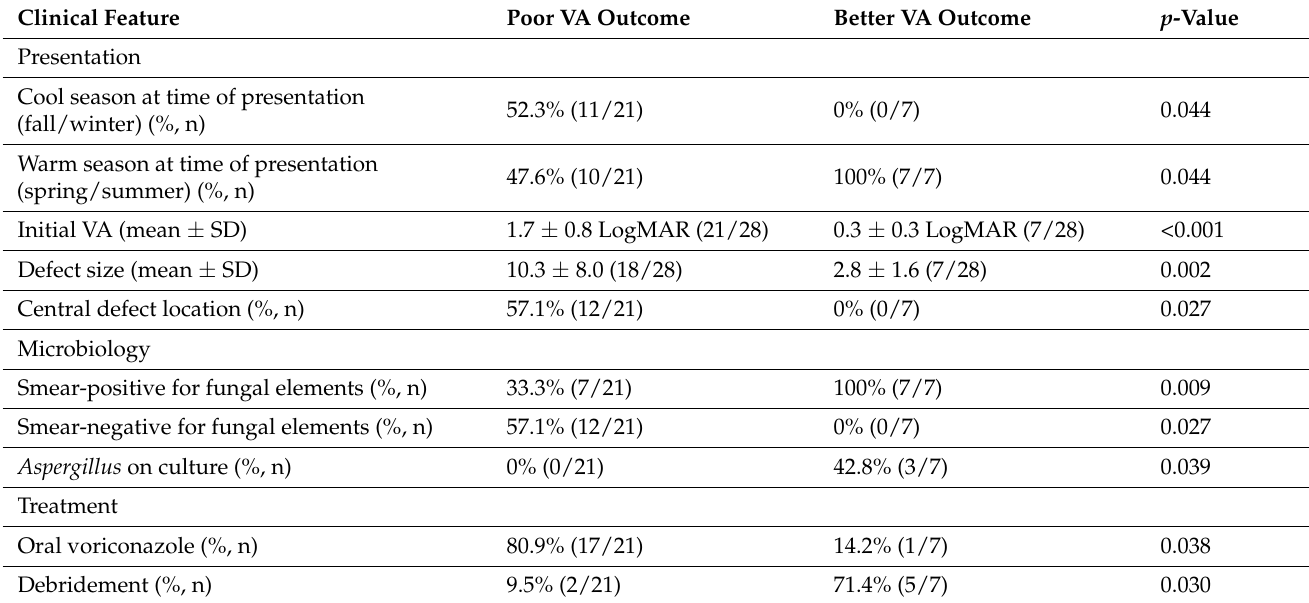
Table 4. Features on clinical presentation that were significantly different between patients with a poor visual outcome (VA less than 20/40) vs. patients with a better visual outcome (VA greater than 20/40).